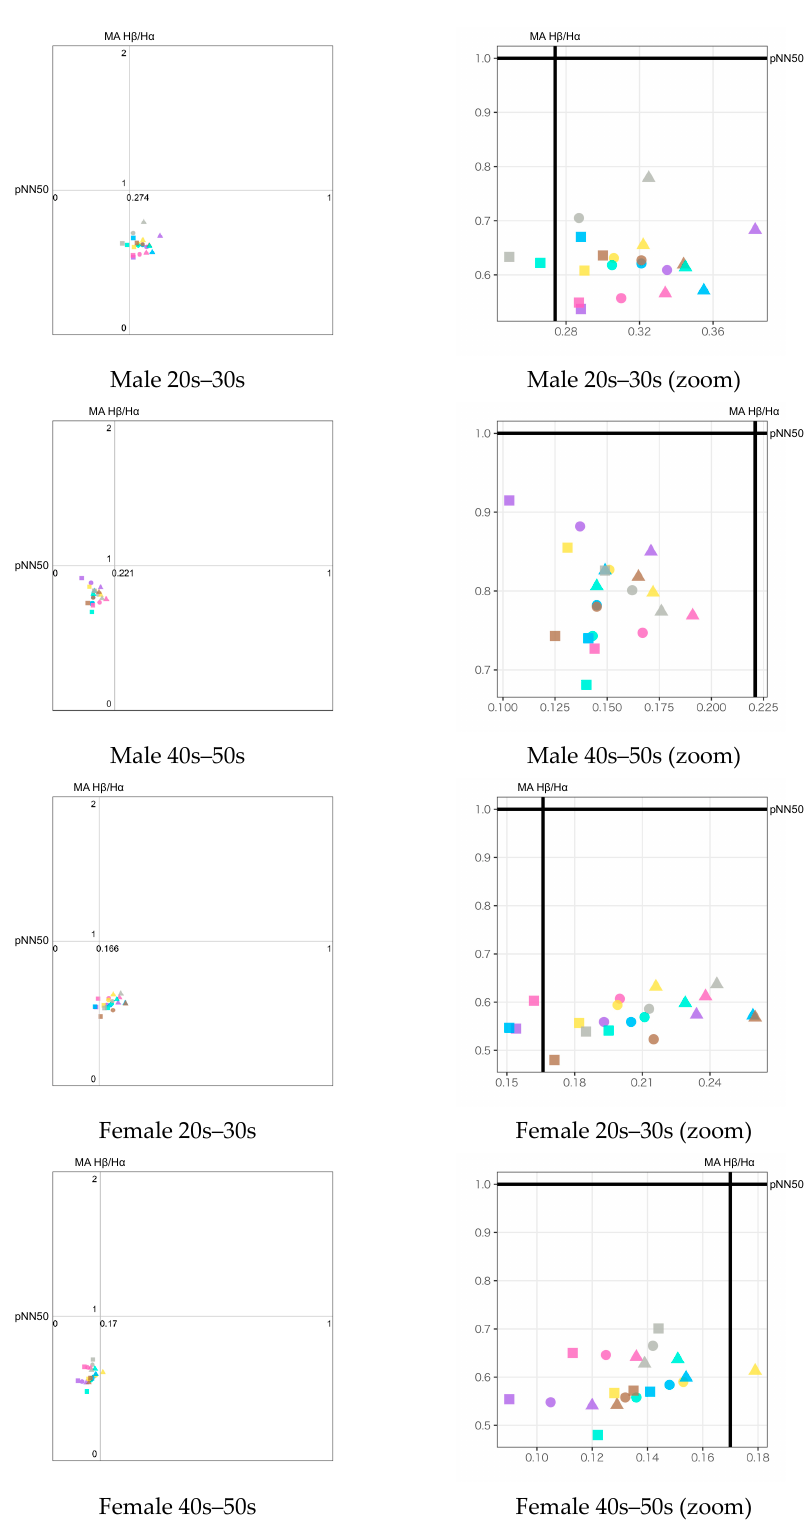
of the emotion maps on the left for a closer observation of the plots. The dots with di ff erent colors indicate the di ff erent olfactory stimuli as shown in the legend (Figure 10).